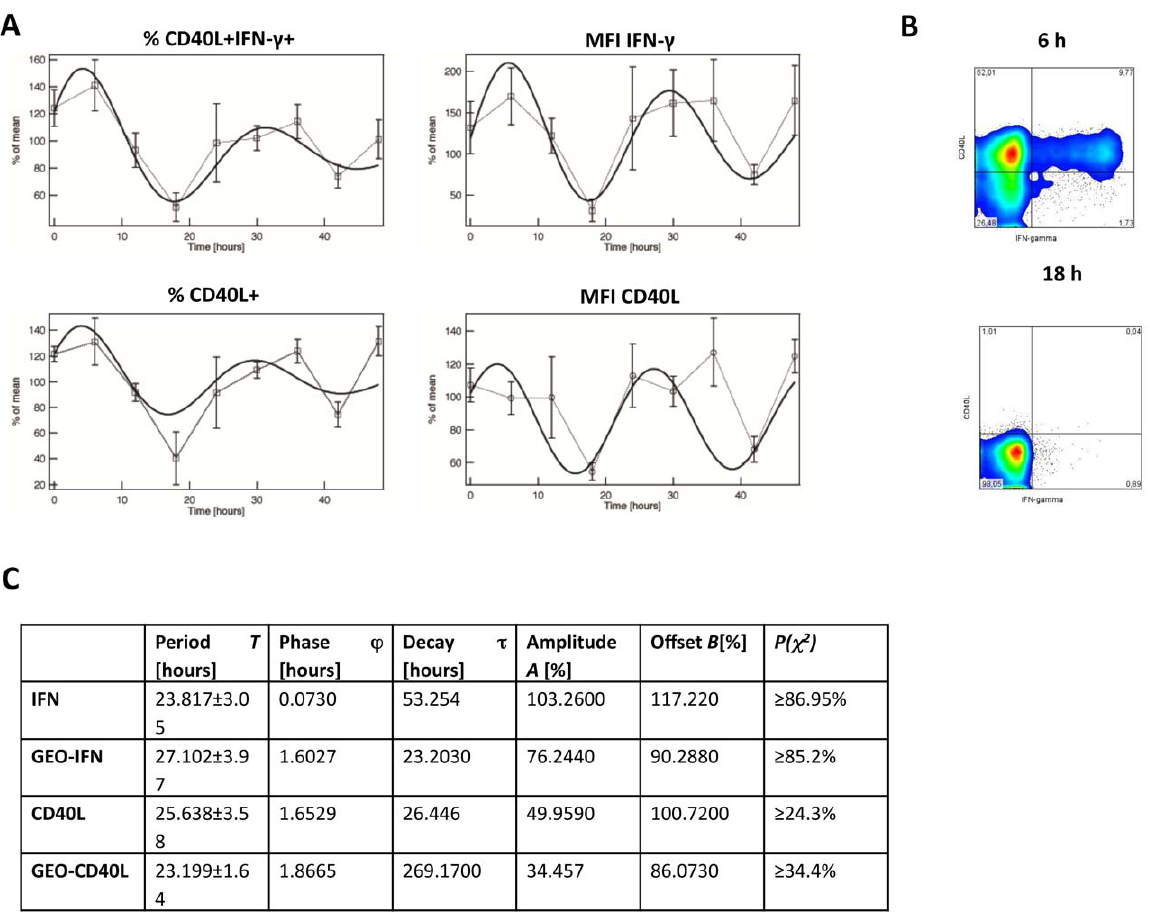
Figure 5. Circadian immune response of stimulated CD4 + T cells in vitro. Blood was sampled from four healthy young males at 10 AM. CD4 + T cells were isolated from whole blood by MACS technology and the purified CD4 + T cells (mean purity: 91.14% 6 0.82%) were subsequently cultured in serum-free medium and stimulated with PMA/ionomycin. A) Depicts the expression (GeoMean) as ‘‘percent of mean’’ of IFN- c (mean=207.74) and CD40L (mean=54.56) per cell as well as the ‘‘percent of mean’’ of the percent of CD40L + CD4 + (mean=63.16%) and CD40L + IFN- c + CD4 + T cells (mean=9.8%). The x-axis reflects the time cells were in culture. The statistical analyses of the fitting are shown in the table (C). The p-values calculated by Cosinor analysis are depicted in Table. S2. B) Shows two FACS plots of one donor at the peak and trough of IFN- c production (time point as indicated).